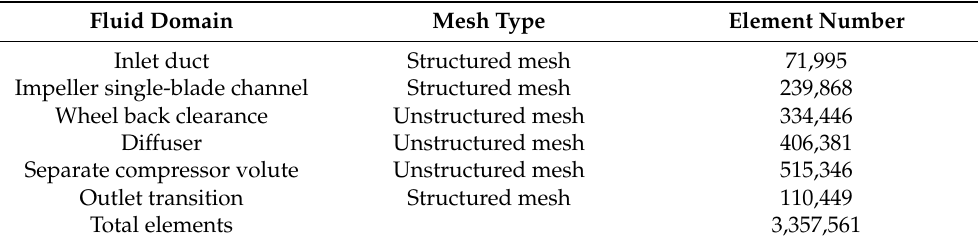
Figure 4. ( a ) Original compressor whole-stage fluid domain; ( b ) original turbine whole-stage fluid domain. Table 3. The elements for the compressor model.